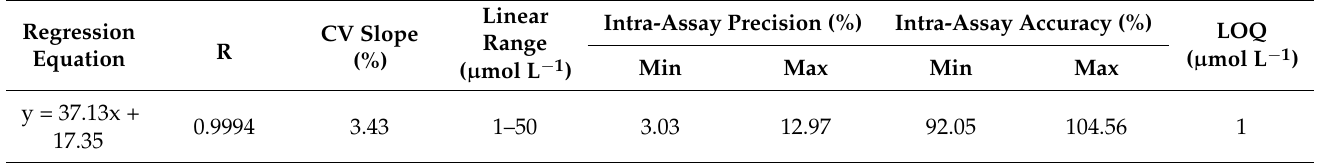
Table 2. Validation data corresponding to intra-assay measurements ( n =